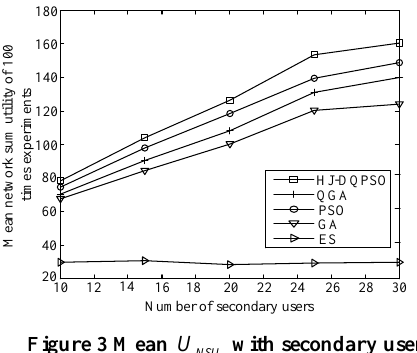
U with secondary users NSU